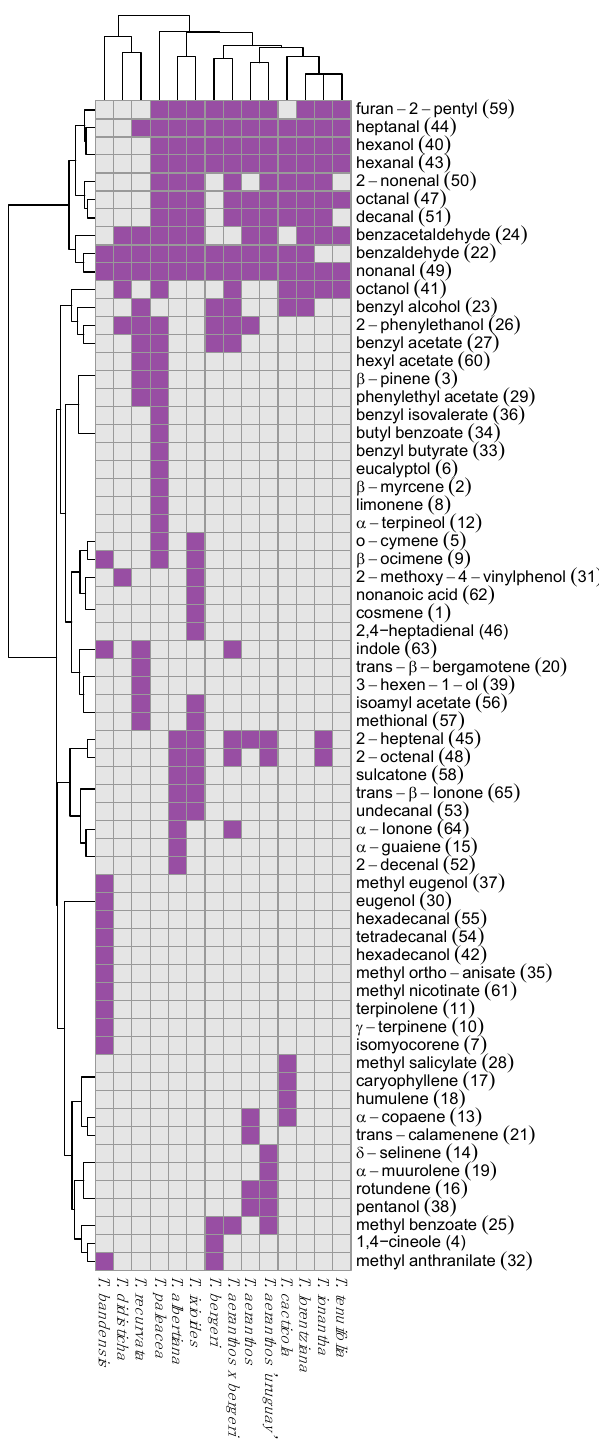
Figure 1. Heatmap from the 14 flowers, in which VOCs were identified or not. Purple represents the volatile organic compounds, which were identified in the corresponding Tillandsia species, while grey represents the non-identified compounds. To help with the identification of the volatile compounds that allow us to highlight similarities or differences between the 14 different species, a principal component analysis (PCA) was used to analyze the 65 compounds identified in this study.